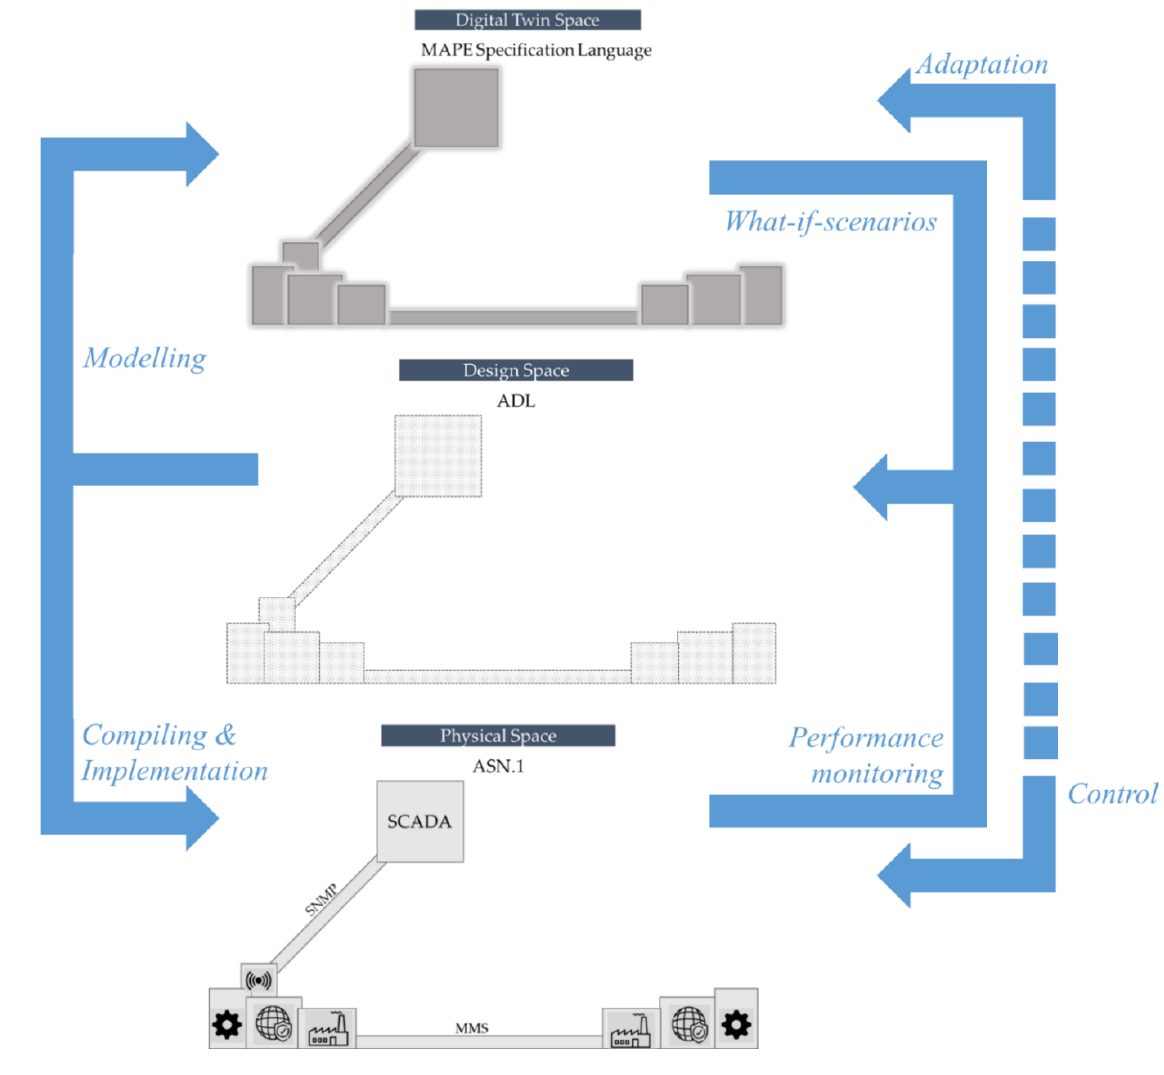
Figure 2. Three distinct phases and the corresponding languages that can be developed. SNMP, MAPE and architecture description languages (ADL) are mentioned.